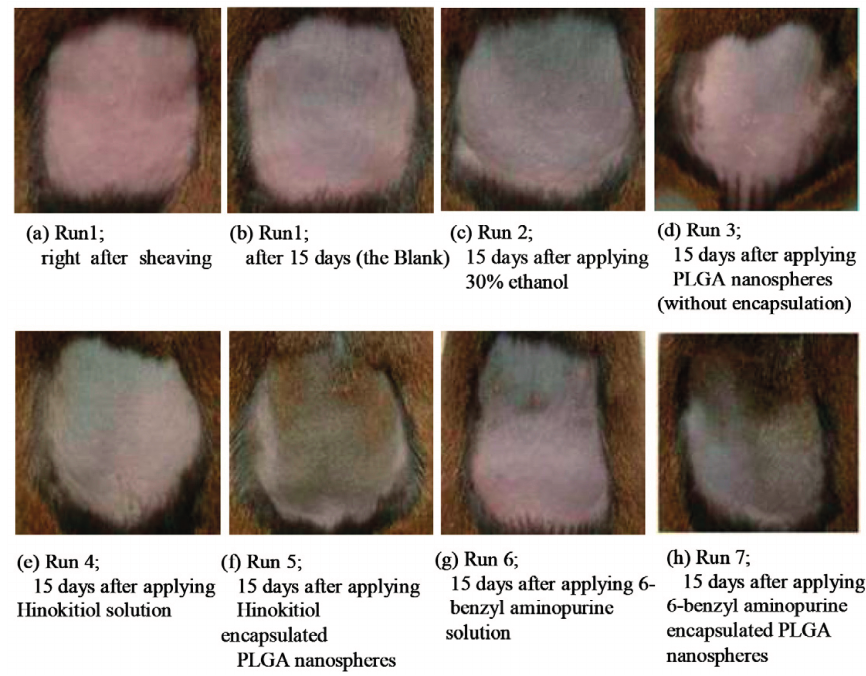
Figure 5. Evaluation of hair growth after application of a variety of hair growing ingredient encapsulated PLGA nanospheres. Mice are shown just after shaving ( a ) without applying any test liquid for 15 days ( b ) and 15 days after applying 30% ethanol ( c ), empty PLGA nanospheres ( d ), hinkokitiol solution ( e ), PLGA nanospheres encapsulated with hinkokitiol ( f ), 6-benzyl aminopurine solution ( g ), and PLGA nanospheres encapsulated with 6-benzyl aminopurine solution ( h ). Fur growth index (mean ± SD) was 1.1 ± 0.33 ( b ), 1.5 ± 0.075 ( c ), 1.7 ± 0.75 ( d ), 1.5 ± 0.50 ( e ), 2.3 ± 0.47 ( f ), 1.5 ± 0.76 ( g ) and 2.3 ± 1.11 ( h